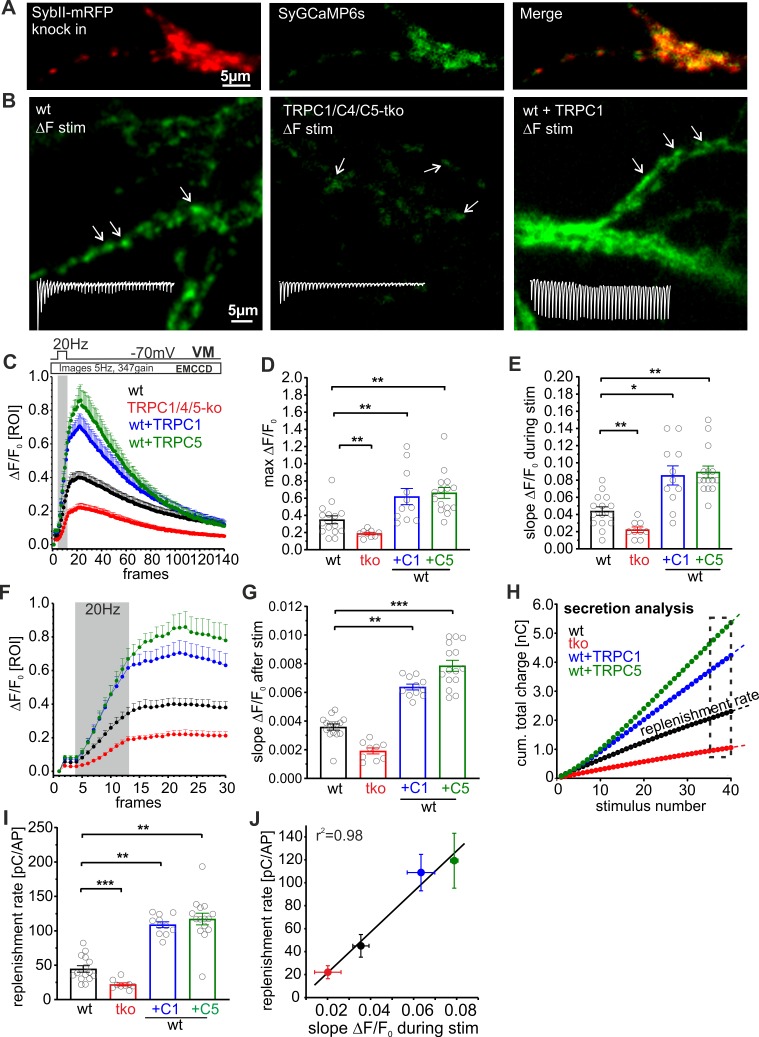
TRPC channels augment the presynaptic Ca2+-rise upon HFS.(A) Exemplary images of neurons expressing the vesicular protein SybII-mRFP (left) and Synaptophysin-GCaMP6s (SyGCaMP6s, middle). Note the high degree of colocalization between synaptobrevinII and SyGCaMP6s (right). (B) Sample difference images (ΔF/F0) of SyGCamp6s signaling recorded (5 Hz) from autaptic neurons (wt, left; tko, middle; wt + TRPC5, right) during the HFS (20 Hz, 2 s); insets are corresponding EPSC recordings from the same cell. Arrows are exemplary ROIs used to monitor ΔF/F0 at single synaptic sites. (C) Loss of TRPC channels decreases the presynaptic Ca2+ rise, whereas expression of either TRPC variant strongly increases the Ca2+ signal. (D) Maximum ΔF/F0 from the data shown in (C), tko, p = 0.006; +C1, p = 0.0076; +C5, p = 0.0023. (E) TRPC deficiency decreases, whereas TRPC expression increases the slope of ΔF/F0 during HFS (slope between the 6th and the 13th data point; tko, p = 0.003; +C1, p = 0.035; +C5, p = 0.002. (F) Expansion of the early phase of the plot shown in panel C illustrating the prolonged Ca2+ rise after HFS. (G) Expression of either TRPC variant significantly enhances the Ca2+ influx right after HFS (slope determined between the 14th and 20th data point; tko, p = 0.48; +C1, p = 0.025; +C5, p = 0.0003). (H) Corresponding mean cumulative total charge transfer of the neurons imaged in panel C. (I and J) The replenishment rate (determined from the slope of the cumulative plot, last 4 data points, shown in panel H, is significantly changed by altering TRPC expression (I) and correlates with changes in SyGCaMP6s (slope of ΔF/F0) during HFS); tko, p = 0.0002; +C1, p = 0.009; +C5, p = 0.0004. Data were collected from wt, n = 15; tko, n = 9; wt + TRPC1, n = 11; wt + TRPC5, n = 15; *p < 0.05; **p < 0.01; ***p < 0.001; one-way ANOVA on ranks followed by Dunn’s post hoc test versus wt. wt versus tko Mann-Whitney rank sum test. Underlying data can be found in S1 Data. AP, action potential; EMCCD, electron multiplying charge coupled device; EPSC, evoked postsynaptic current; HFS, high-frequency stimulation; mRFP, monomeric red fluorescent protein; ROI, region of interest; SybII, synaptobrevin II; SyGCaMP6s, Synaptophysin-GCaMP6s; tko, triple knockout; TRPC, transient receptor potential canonical; VM, membrane voltage; wt, wild type; ΔF, delta fluorescence.